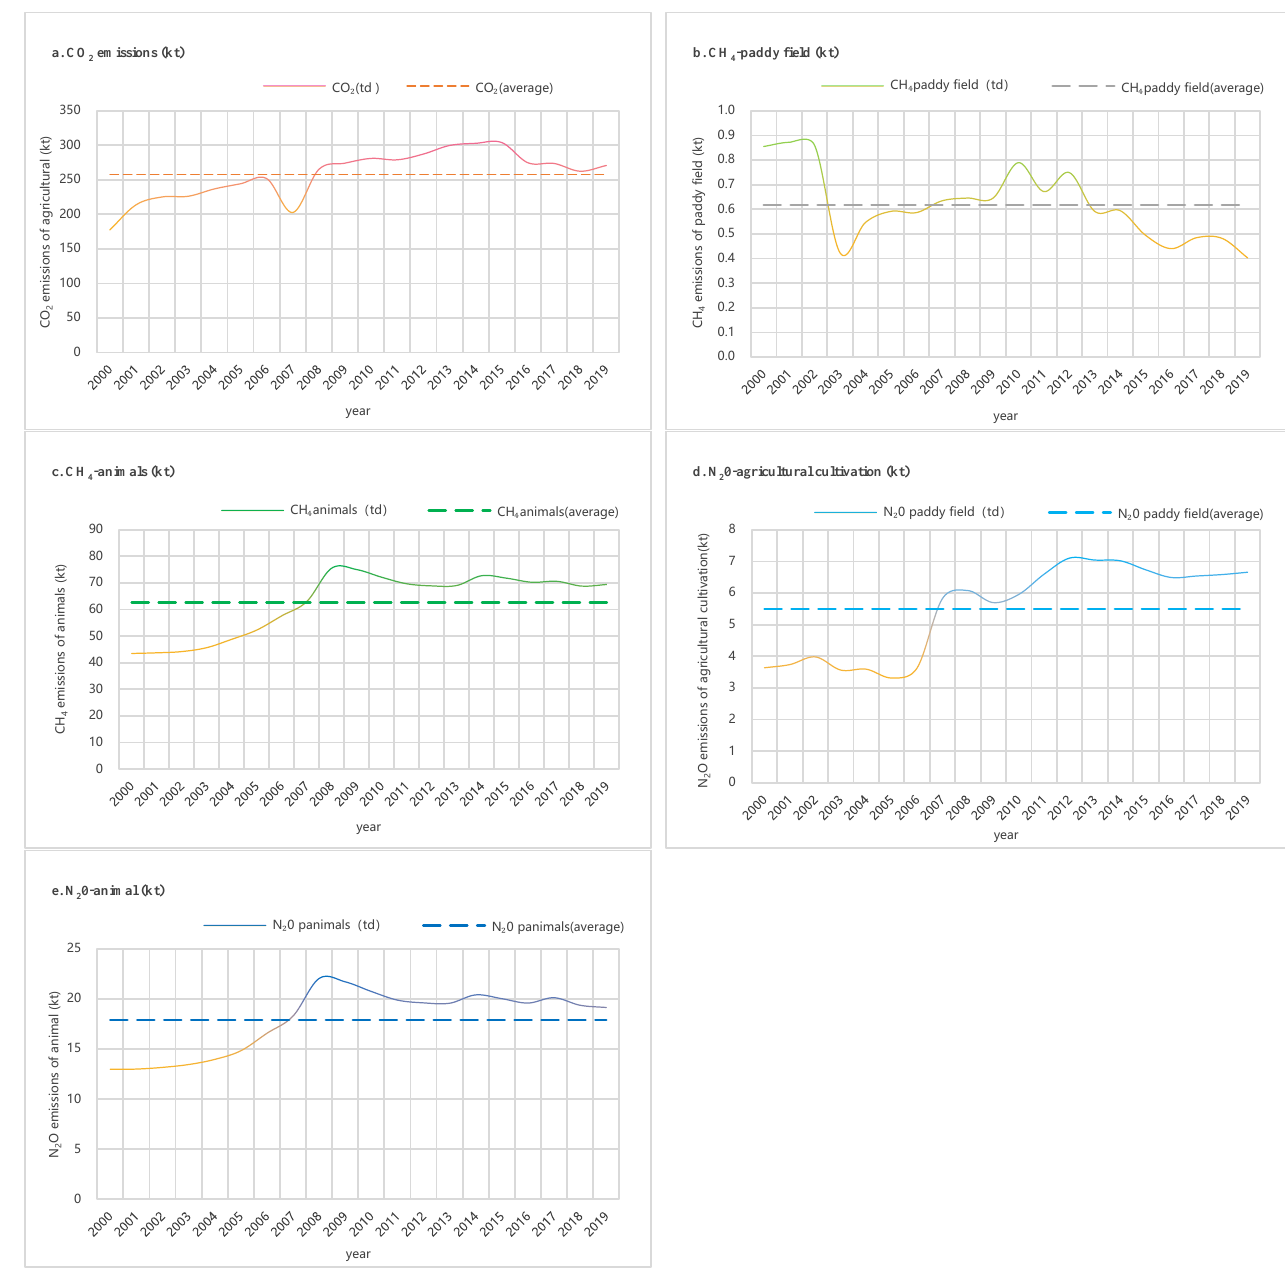
Figure 3. Variations in ( a ) CO 2 emissions, ( b ) CH 4 emissions of paddy field, ( c ) CH 4 emissions of animals, ( d ) N 2 O emissions of paddy field, ( e ) N 2 O emissions of animals. Different types of agricultural GHG analysis. The Changes of the total of different types of agricultural GHG in The Main Stream of the Yellow River Basin in Gansu section from 2000 to 2019.” kt” stands for “ thousand tons ” .